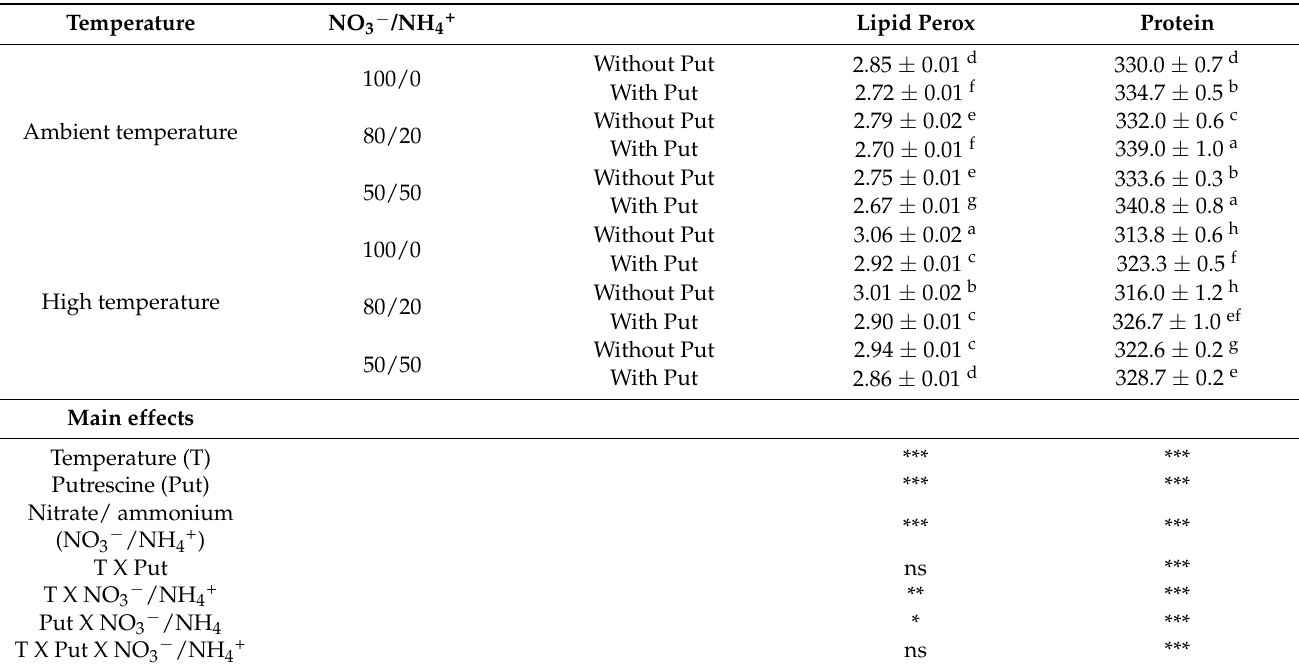
Table 4. Effect of foliar application of putrescine on lipid peroxidation (TBARS µ mol g − 1 FW) and proteins (g kg − 1 DW) in outer leaves of the cauliflower cv. Moonshine at different ration of NO 3 − /NH 4+ and